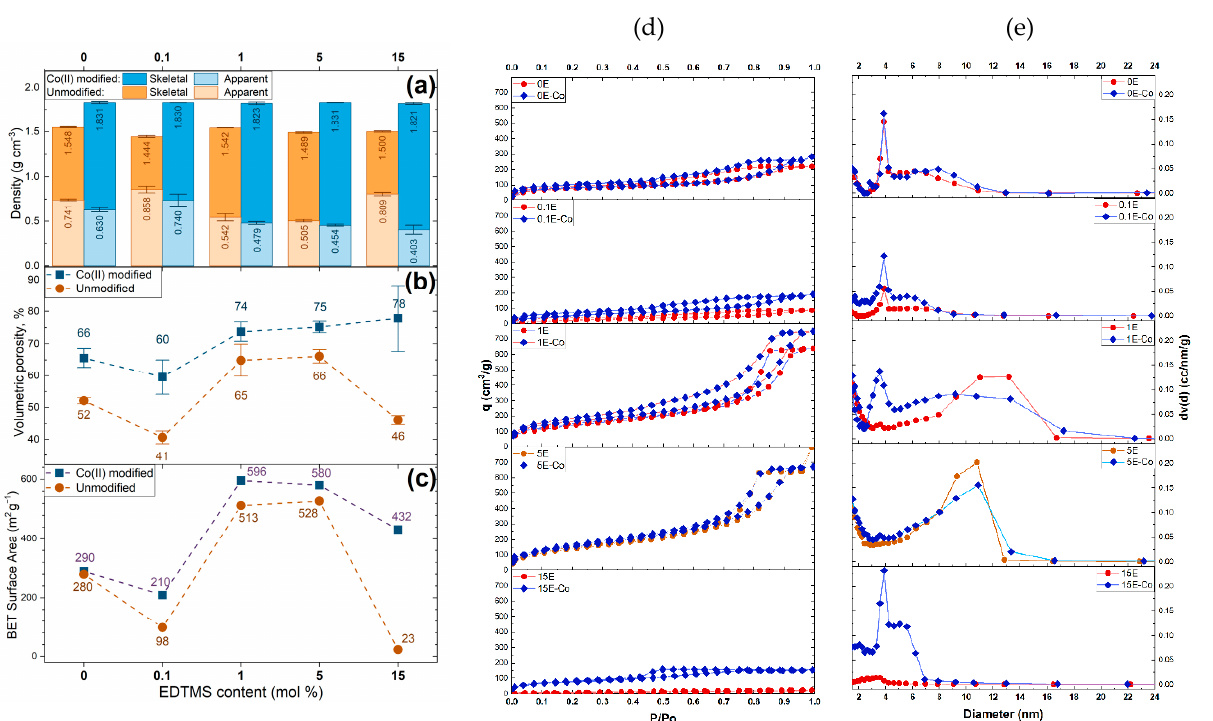
Figure 8. Textural properties of the cobalt-modified and bare aerogels: ( a ) skeletal and apparent density, ( b ) volumetric porosity, ( c ) BET surface area, ( d ) low-temperature nitrogen adsorption- desorption isotherms, ( e ) calculated BJH pore-size distribution for obtained aerogels (from the desorption